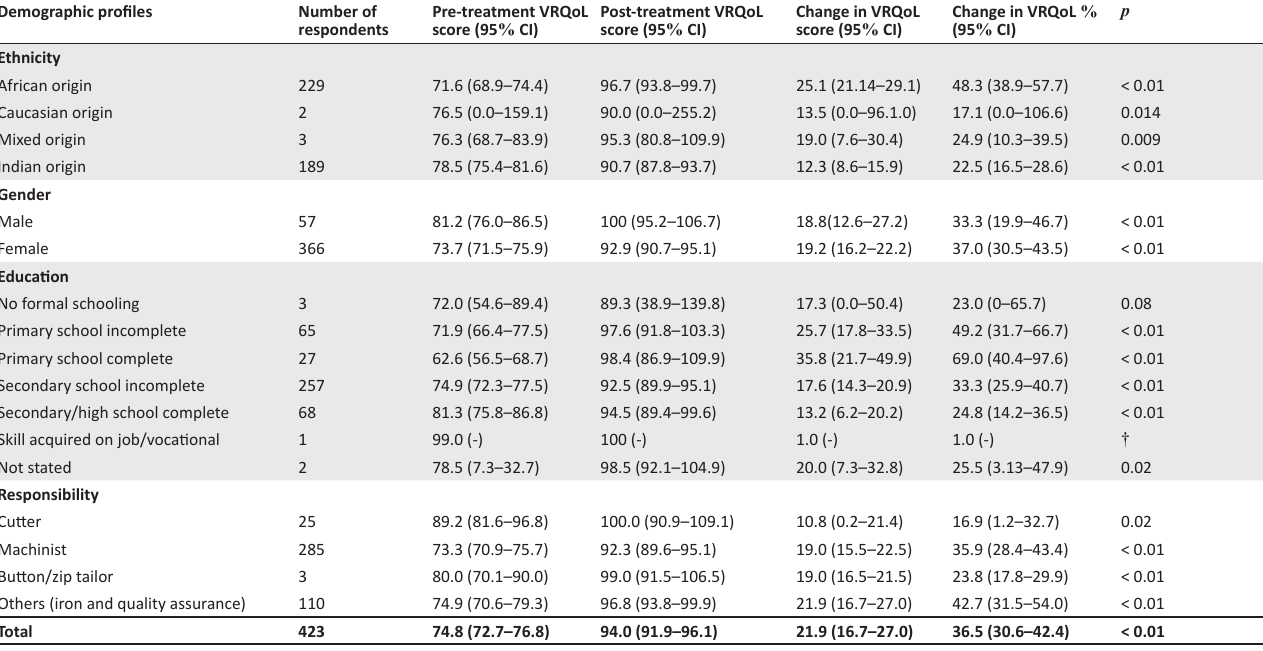
TABLE 3: Changes in mean vision-related quality of life score for respondents. Demographic